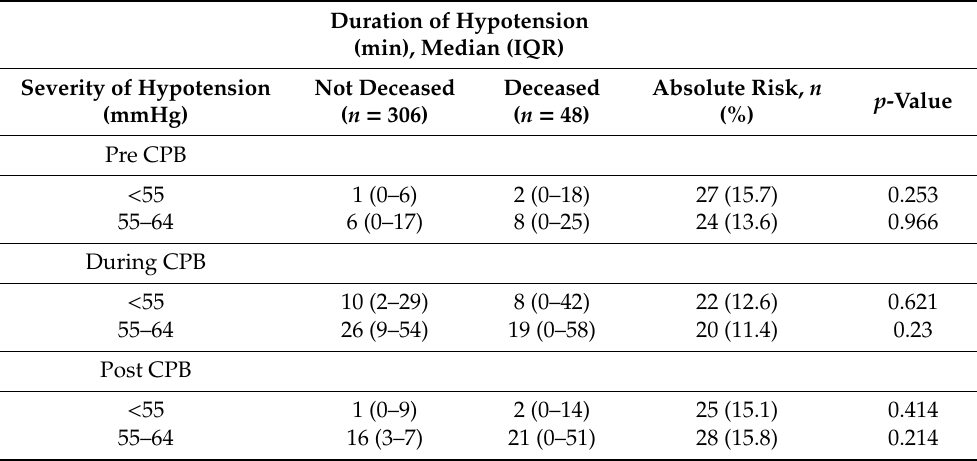
Table 4. Median durations of hypotension before, during and post cardiopulmonary bypass and their corresponding morality risk in high-risk patients. Duration of Hypotension